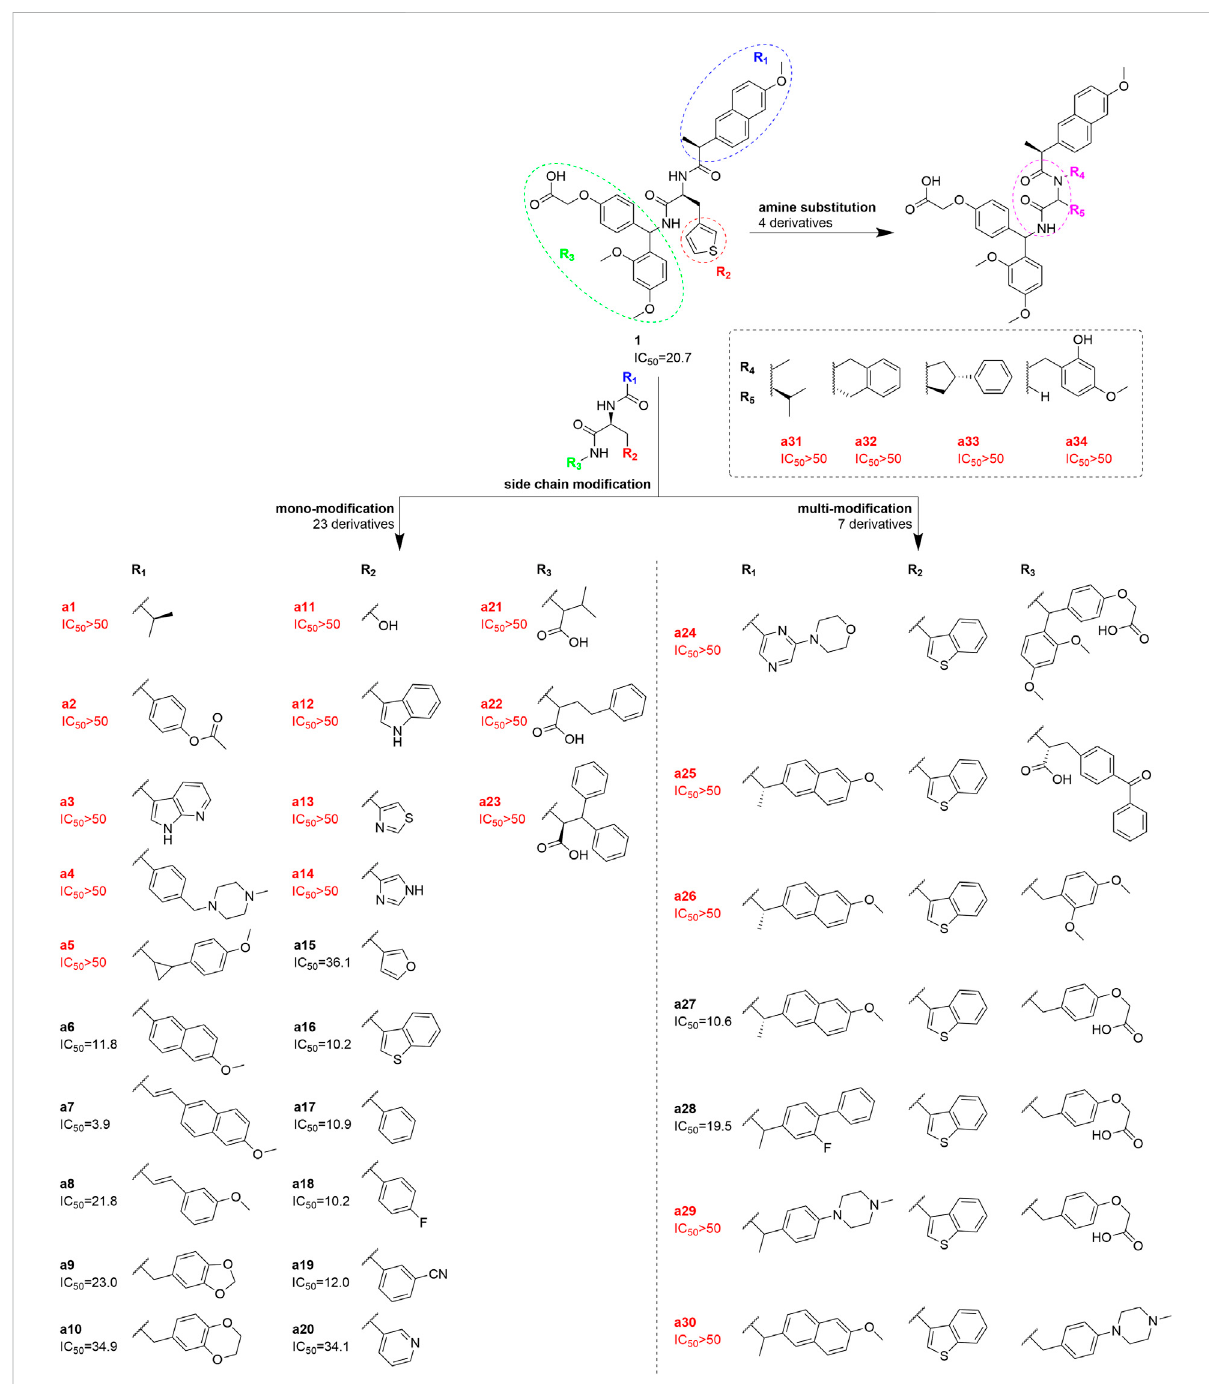
SCHEME 1 The structure and corresponding protein-protein blocking activity for TIGIT/CD155 complex (IC 50 /µM) of compound 1 and its derivatives a1 - a34 . Derivatives a1 - a23 were single-site substituted (R 1 , R 2, and R 3, respectively); Derivatives a24 - a30 were multi-site substituted (R 1 -R 3 ); a31 - a34 were derivatives with modi fi cations including cyclization on the scaffold amine group (R 4 ) and ortho carbons group (R 5